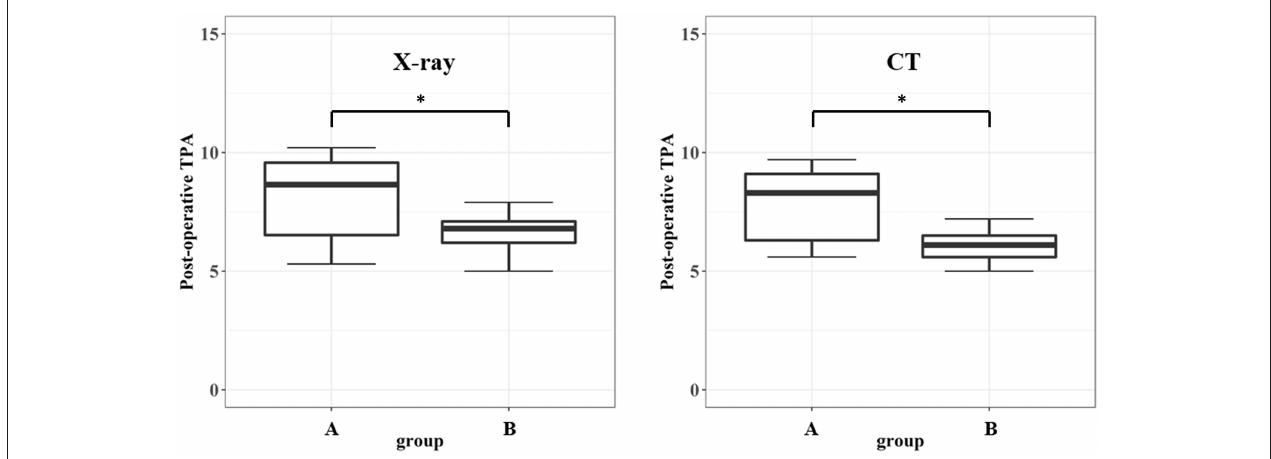
FIGURE 7 | Postoperative tibial plateau angle for the two groups. The conventional TPLO method group has significantly greater postoperative tibial plateau angle than the surgical guide group in both modalities. TPLO, tibial plateau leveling osteotomy. * p < 0.05 is considered statistically significant.